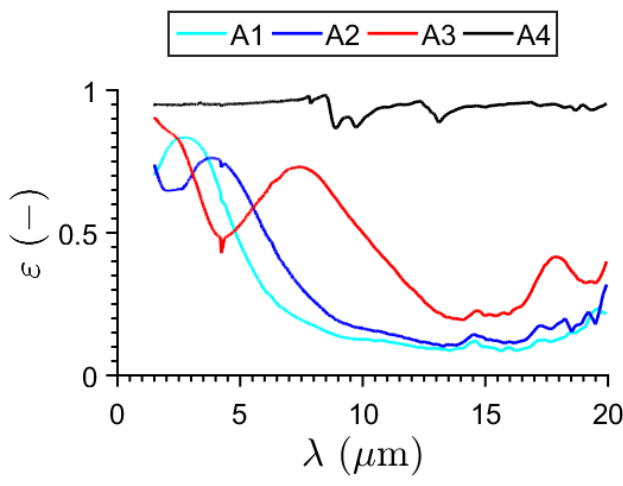
Figure 6. Emissivity of the specimen for different wavelength.